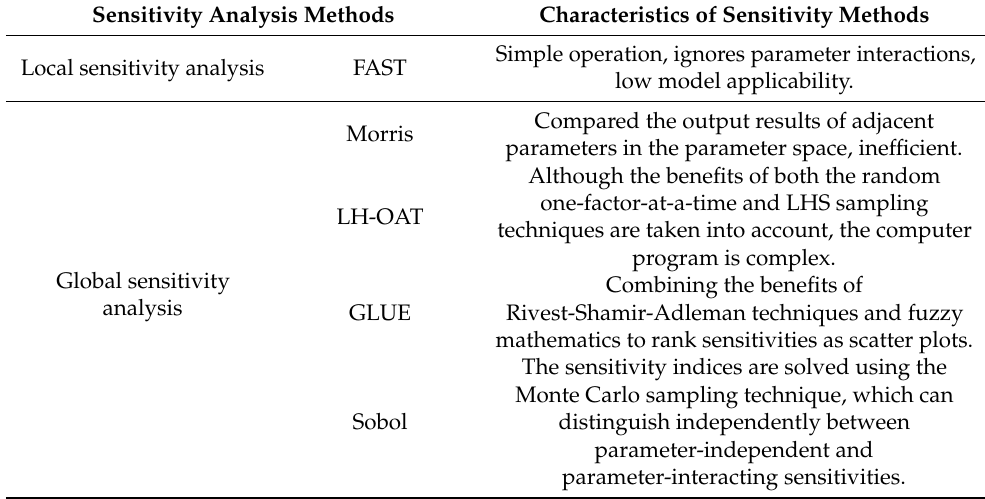
Table 7. Characteristics of sensitivity